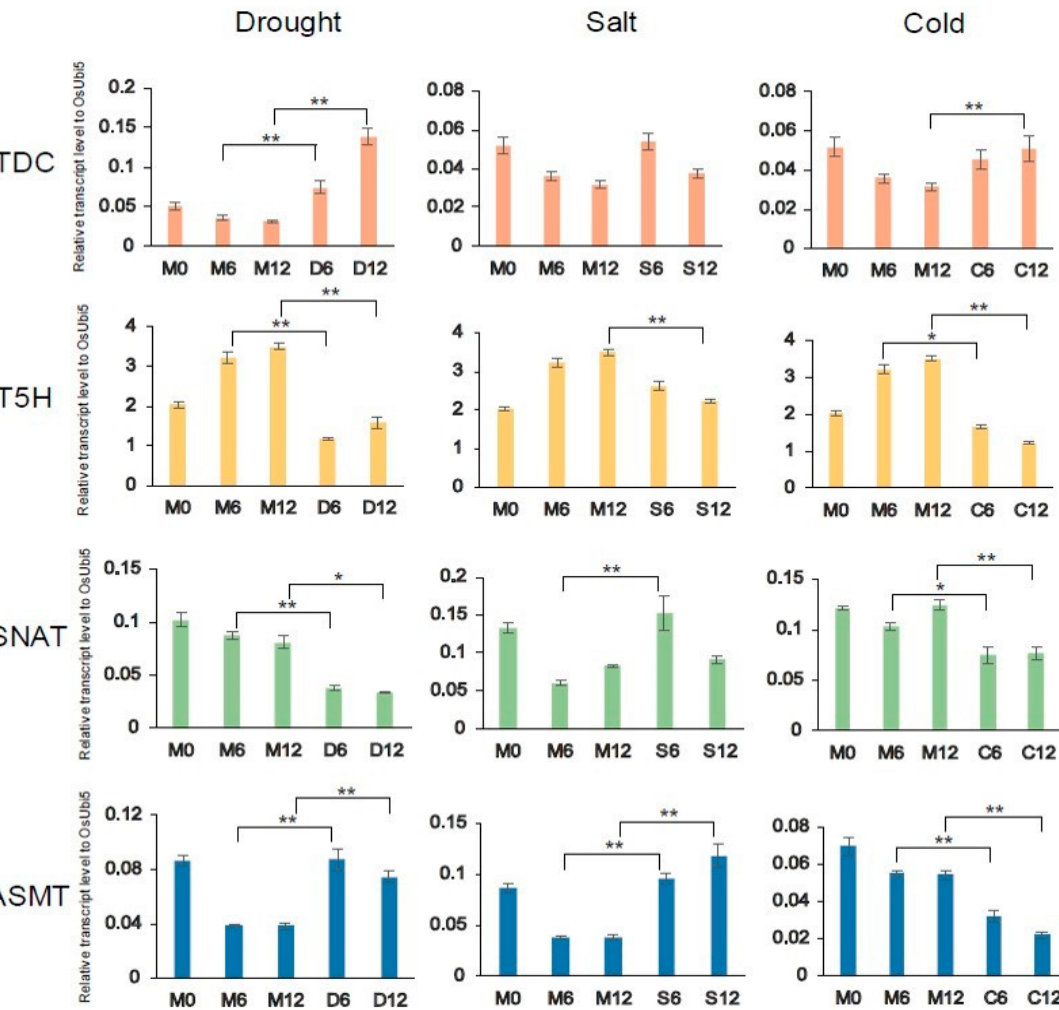
Figure 4. Expression profiles of four melatonin biosynthetic genes under drought, salt, and cold stress, as assessed by qRT–PCR analysis. OsUbi5 was used as the internal control. M—mock; D—drought treatment; S—salt treatment; C—cold treatment. The numbers indicate the time points (h) after stress treatment. ** p < 0.01; * 0.01 < p < 0.05.